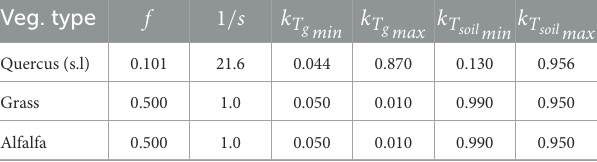
TABLE 2 Vegetation sourcing parameters ( f , s , k T dimensionless) of Equation (9) defined for the La Mata catchment. Veg.